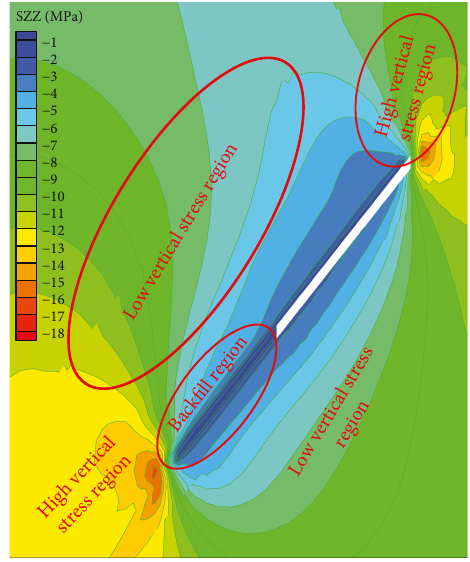
Figure 1: Stress distribution in a